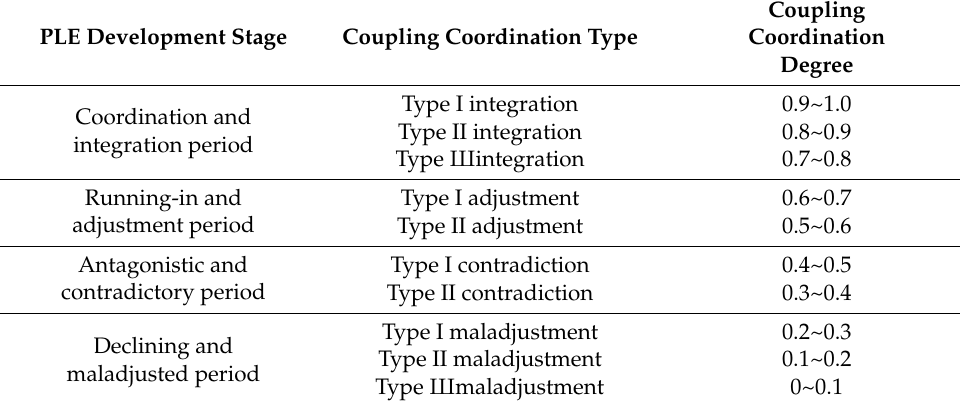
Table 2. Classification of PLE coupling coordination degree.